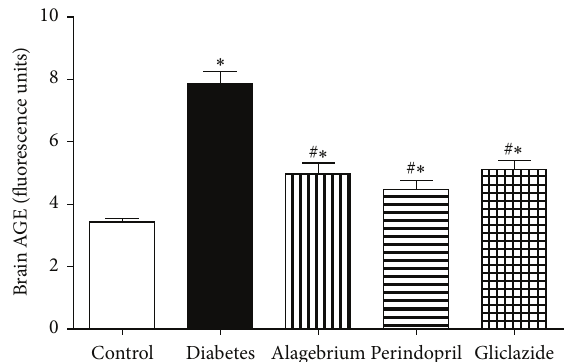
Figure 1: Effects of alagebrium (10mg/kg), perindopril (4mg/kg), or gliclazide (10mg/kg) on brain AGEs level in STZ-induced diabetes in rats. Data are presented as mean ± SEM ( 𝑛 = 6 ). ∗ Significantly different from control group. # Significantly different from diabetic group at 𝑃 < 0.05 using ANOVA followed by Tukey’s post hoc